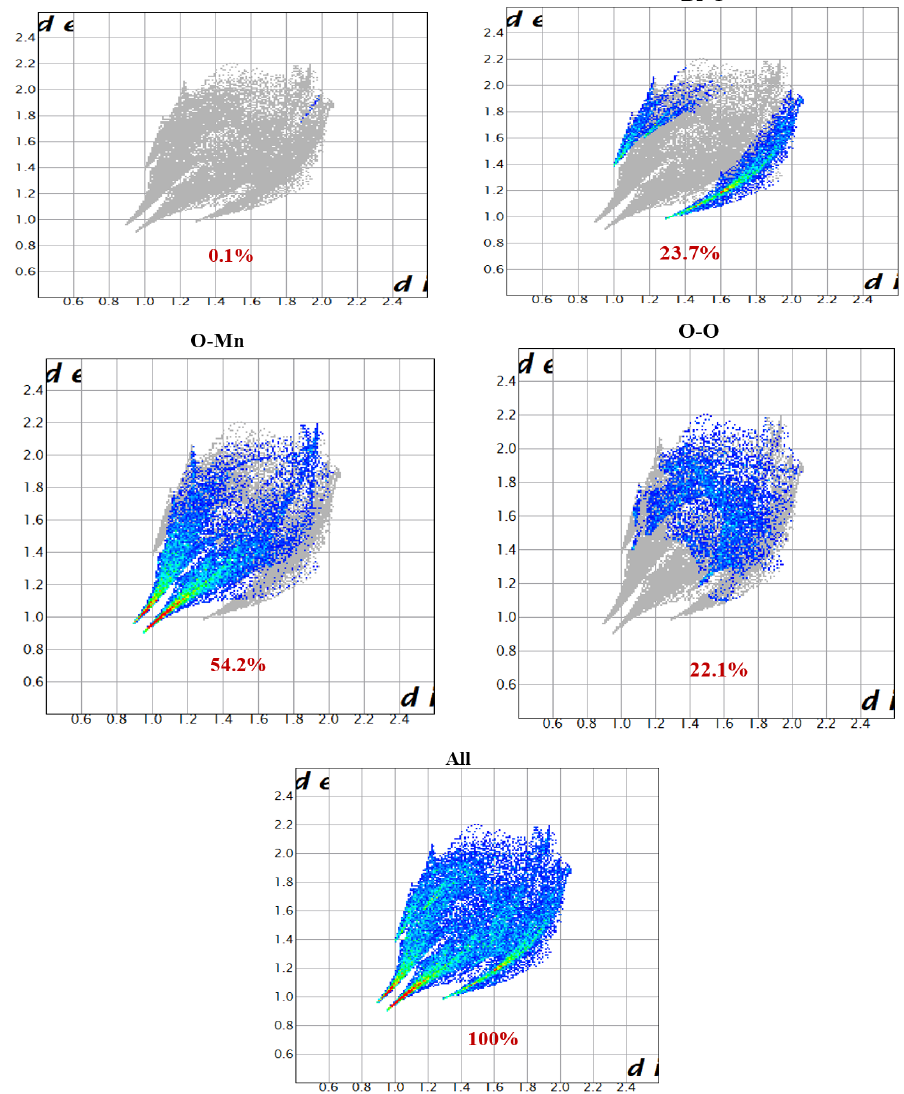
Figure 3. Schematic of creating the fingerprint plots from a Hirshfeld surface. For each location on the surface, the distance to the nearest atom inside the surface ( d i ) and the distance to the nearest atom outside the surface ( d e ) are calculated. These ( d i , d e ) pairs are then binned into a two-dimensional histogram to form the fingerprint plots.